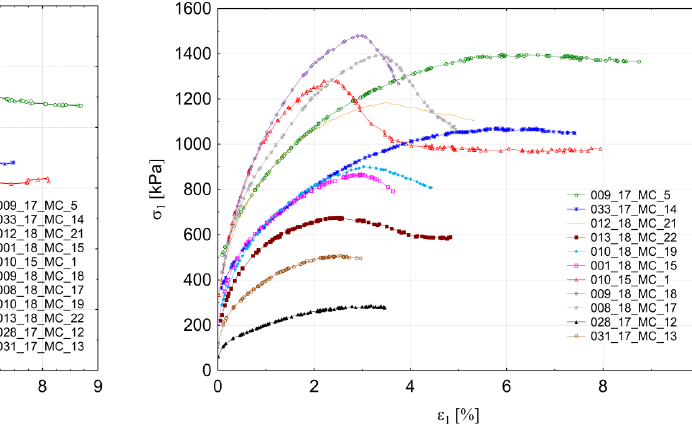
Figure 9: Results of the experimental tests listed in Table 1: maximum principal stress as a function of the axial strain s